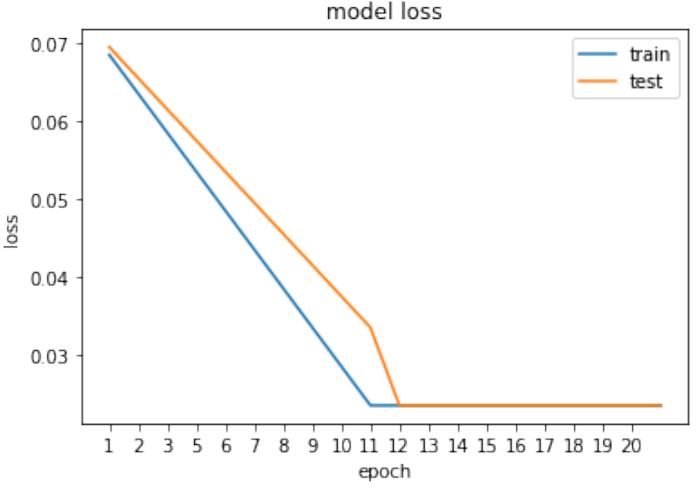
Figure 5. Loss of the proposed model during training and testing using MCAD